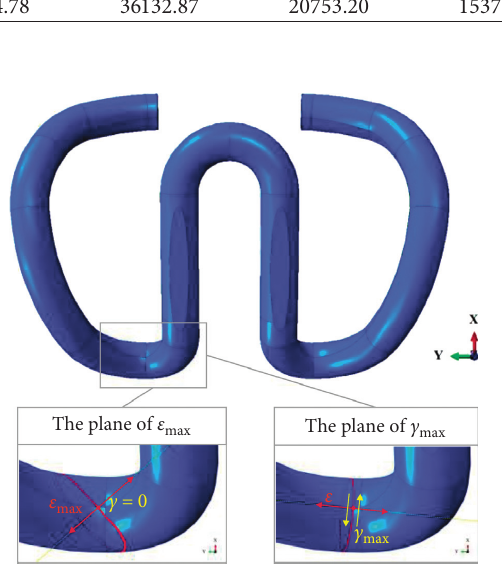
Figure 11: Simulated fracture planes of a fastening clip.